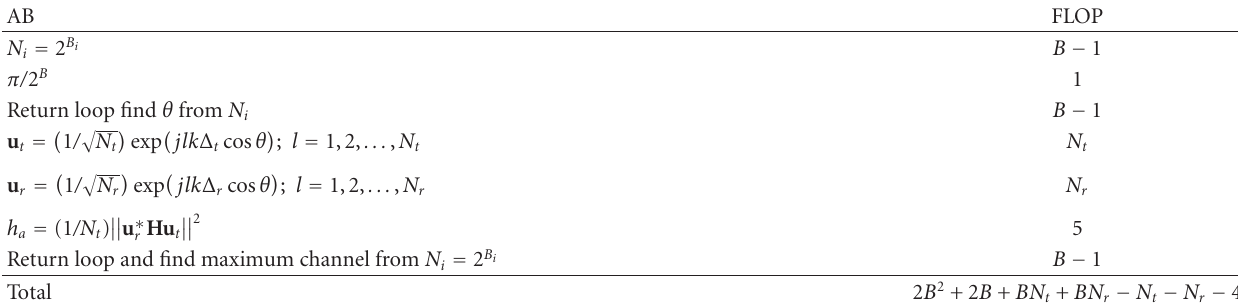
Table 3: The process of formation of FLOP with the AB.